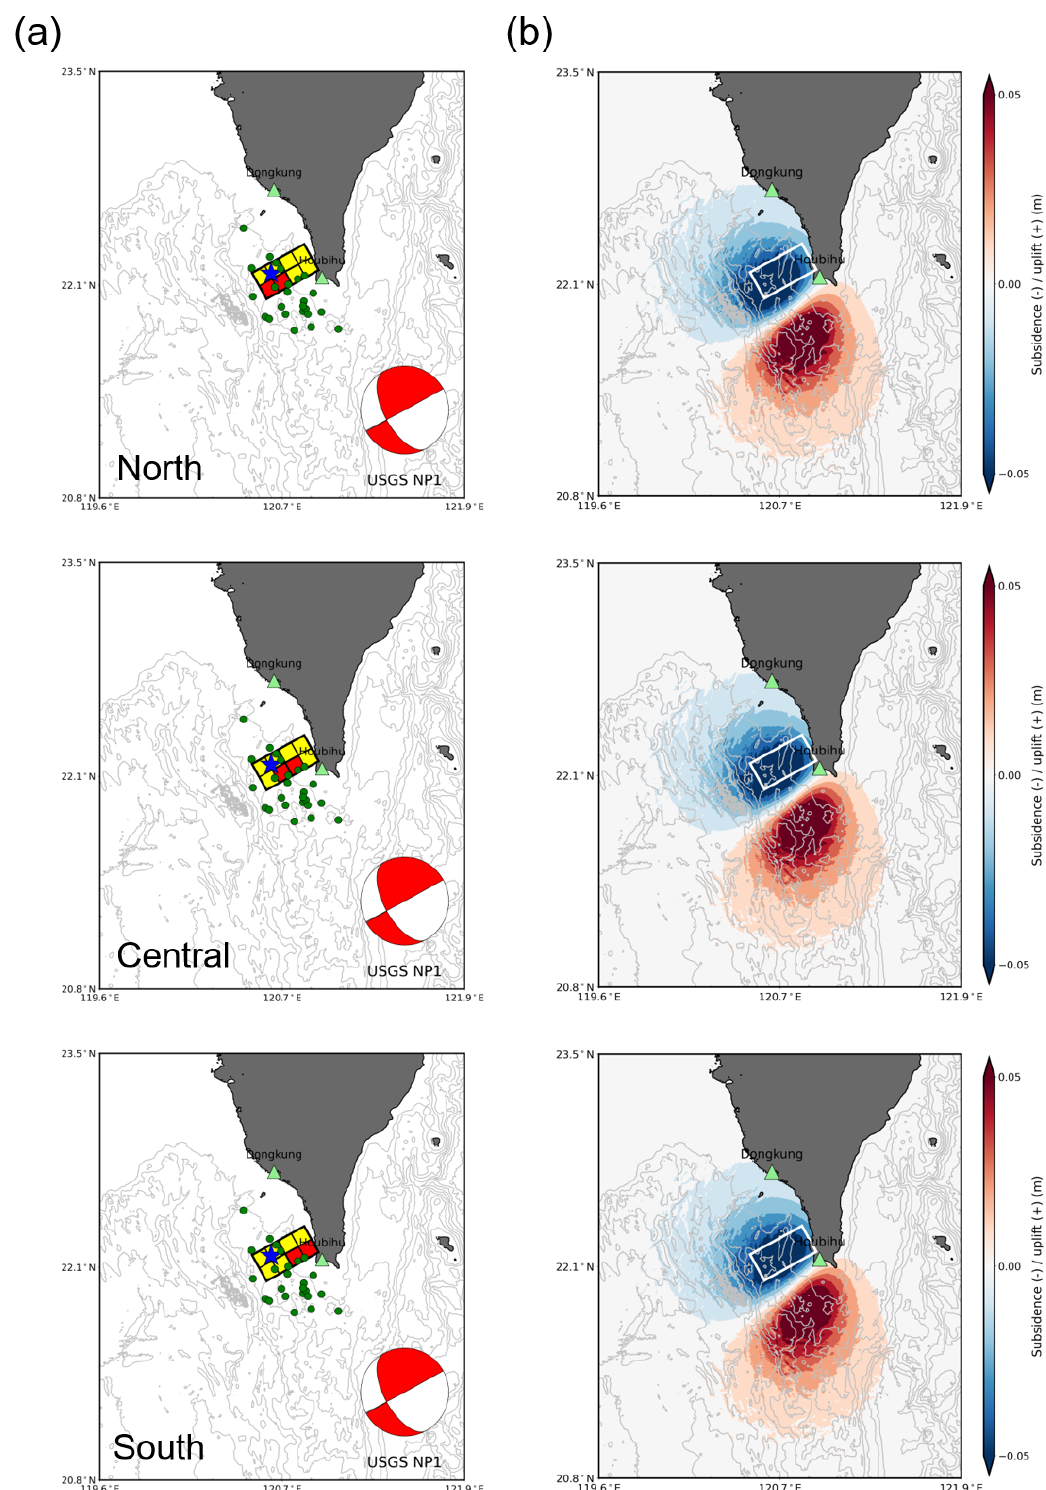
Figure 6. (a) Map of subfault boundaries with three different locations of large slip areas for the second earthquake ( M w 6.9). (b) Coseismic crustal vertical displacement calculated using the fault parameters of the subfaults. The beach ball denotes the focal mechanisms of USGS’s NP2 nodal planes for the first earthquake. The subfaults in red represent large slip areas, and the subfaults in yellow represent background slip areas. The large slip area was located only at the shallow part of the entire fault area. The blue stars represent the epicenter of the first earthquake, and the green circles represent the aftershocks. The tide gauge stations are plotted as green